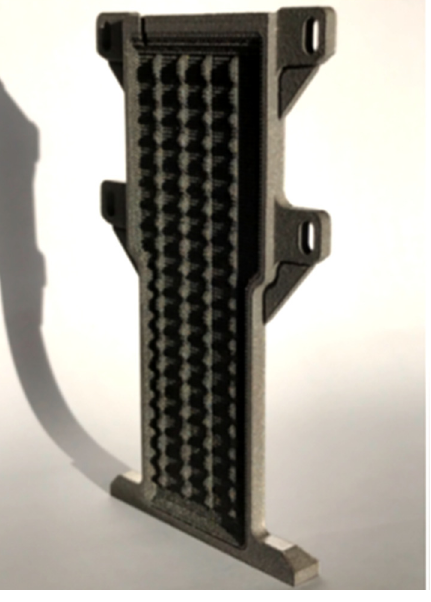
Figure 15. Titanium AM vapour chamber HP with integrated lattice structure [17].